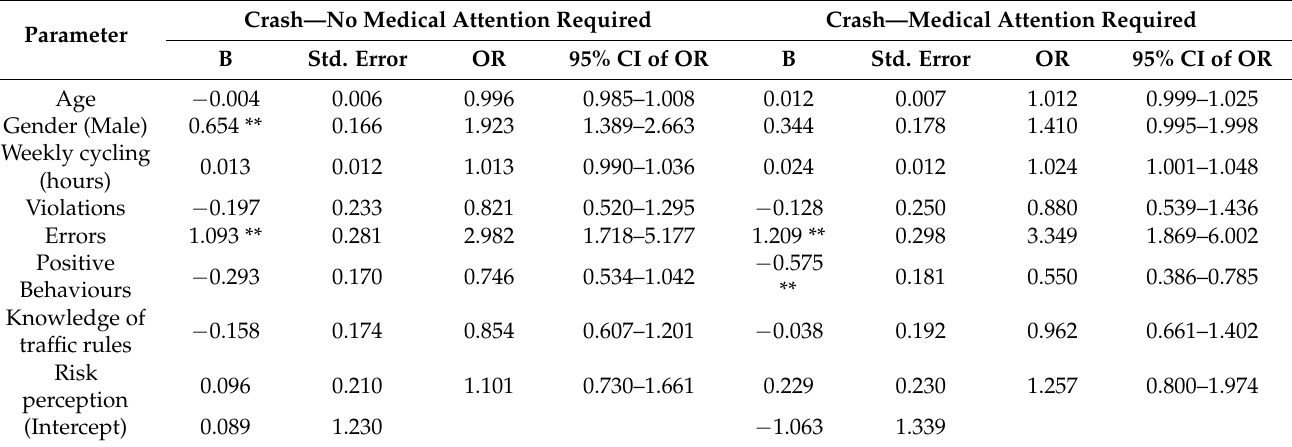
Table 5. Multinomial logistic regression model results for crash